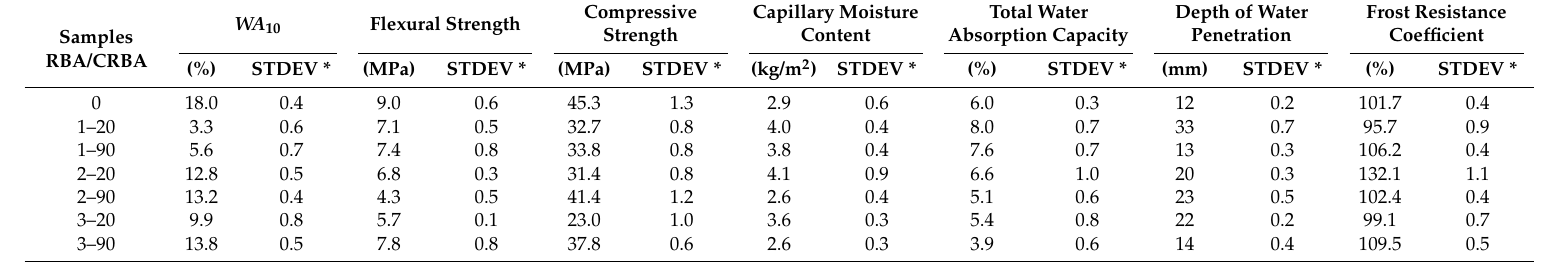
Table 4. Results of short-term water absorption capacity of treated RBA WA 10 and corresponding properties of hardened concrete after 28 day of setting and hardening.